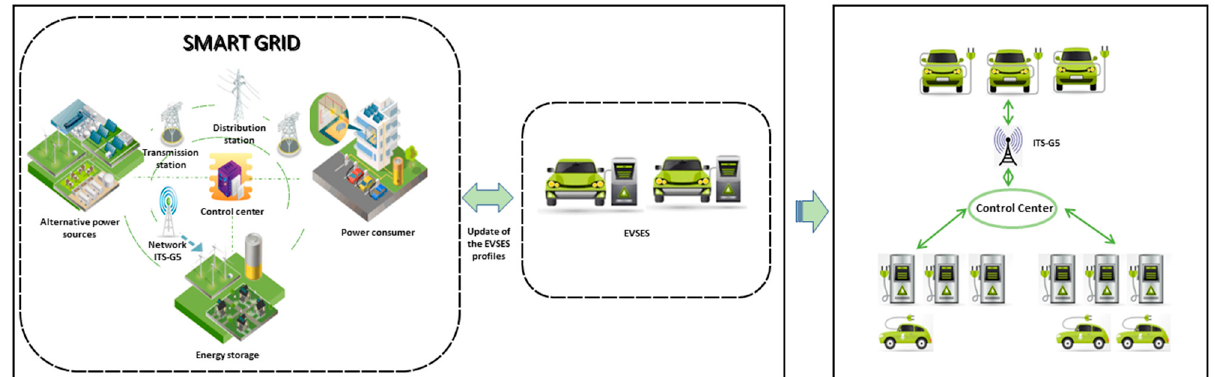
Figure 1. System overview.